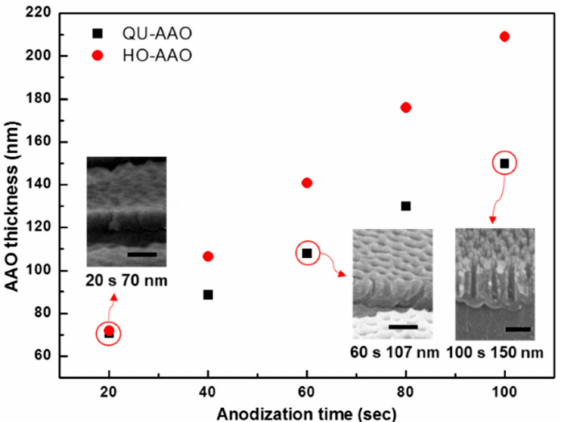
Figure 3. AAO thickness as a function of anodization time. The thickness increases linearly for both of the templates and HO-AAO (red dot) grows faster than QU-AAO (black dot). Insets are cross-section FE-SEM images for QU-AAO templates. The scale bar was 100 nm.